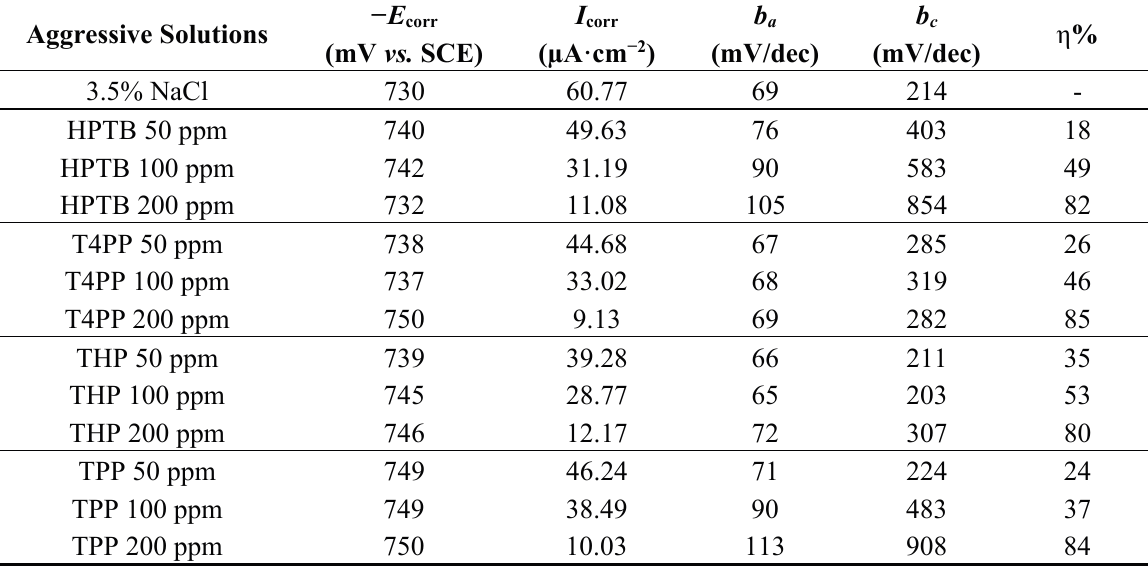
Figure 6. Potentiodynamic polarization curves of N80 steel in 3.5% NaCl saturated with CO 2 without and with various concentrations of ( a ) HPTB; ( b ) T4PP; ( c ) THP and ( d ) TPP. Table 3. Tafel parameters for N80 steel in 3.5% NaCl solution saturated with CO 2 in without and with various concentrations of the studied